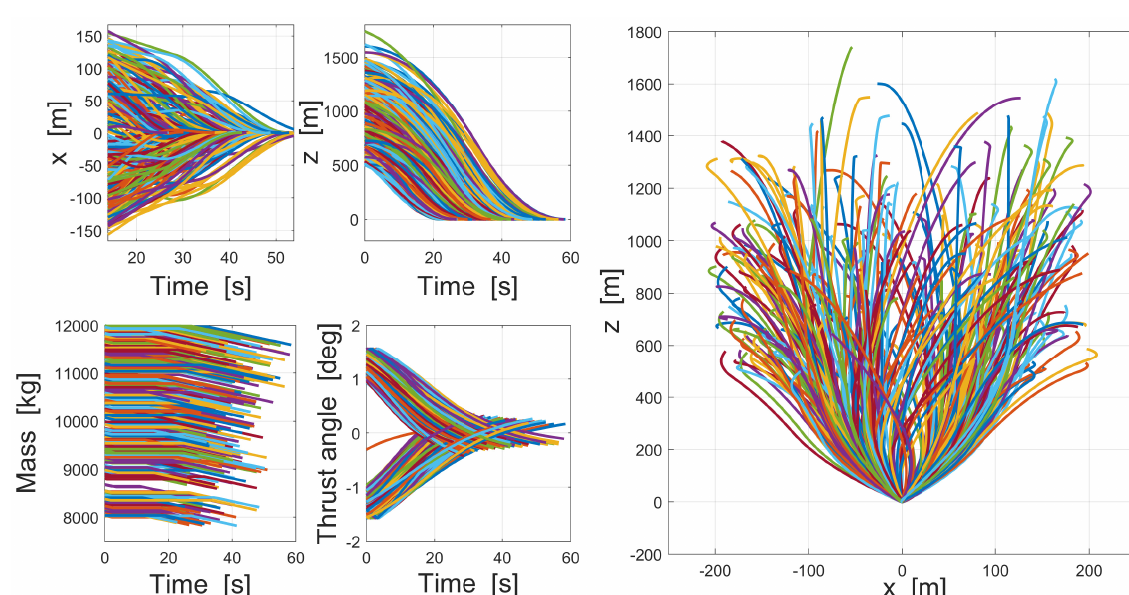
Figure 3. Training dataset of FOML